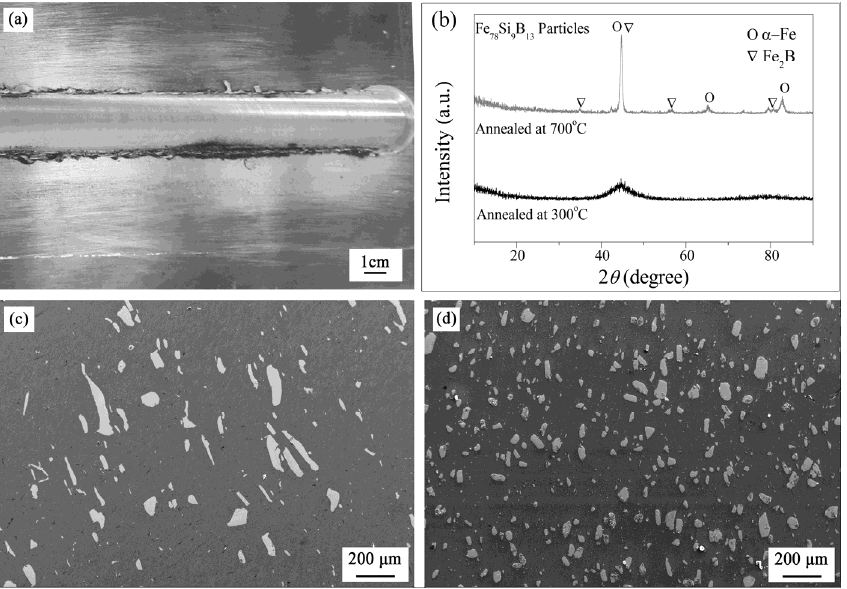
Figure 1. Topography of FSP samples: ( a ) Macrograph of samples after friction stir processing; ( b ) XRD patterns of the reinforced particles; ( c ) SEM photomicrograph of S300; ( d ) SEM photomicrograph of S700.